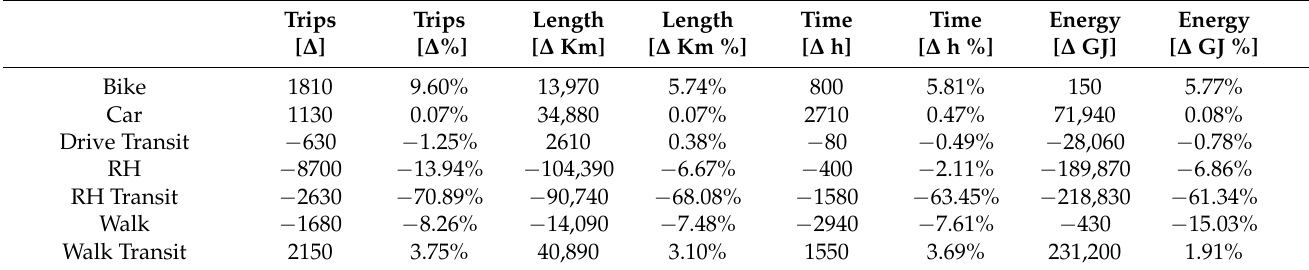
Table 5. Statistics of trips involving Santa Clara County: differences between the baseline and the developing scenarios per transport mode used—interfered to the population; RH = ride hail.